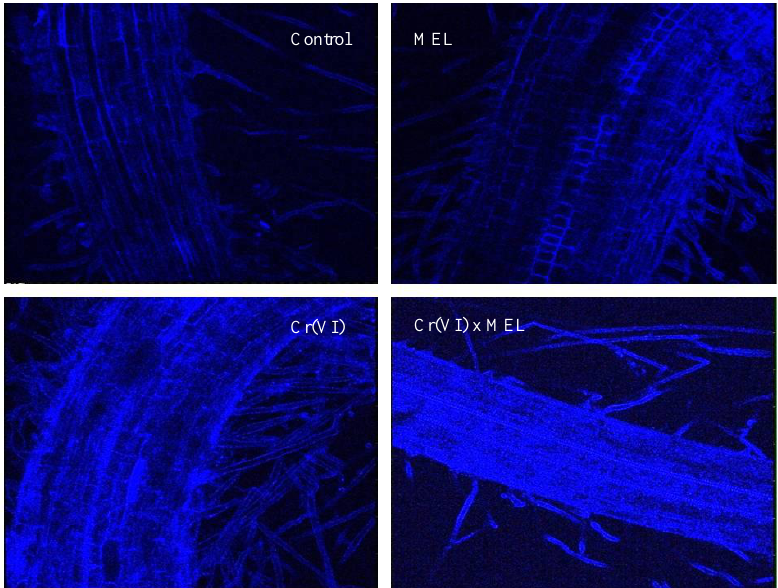
Figure 1. Effect of seed soaking treatment of methanol extract of Rhododendron arboreum leaves (MEL) on glutathione accumulation in Vigna radiata seedlings under Cr(VI) (250 µM) stress.